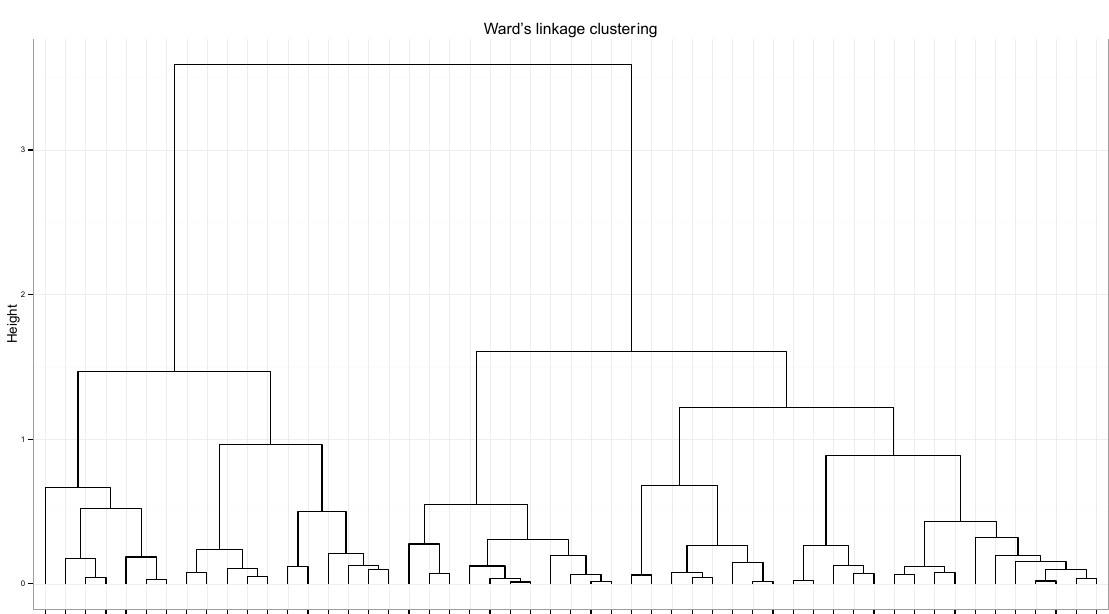
Figure 2. Ward’s Figure 2. Ward’s Dendrogram.